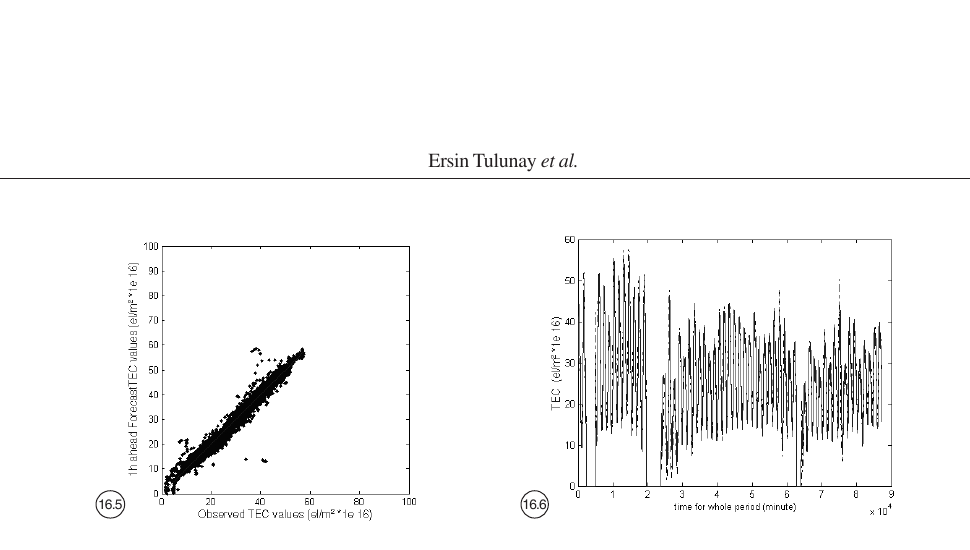
Fig. 16.5. One hour ahead Forecast TEC values versus observed GPS-TEC results (dots) with the linear fit (line). Fig. 16.6. Observed GPS-TEC results (dotted), 3 h ahead Forecast (solid) TEC values for the whole time of vali- dation period: April-May 2002 for Halisham.